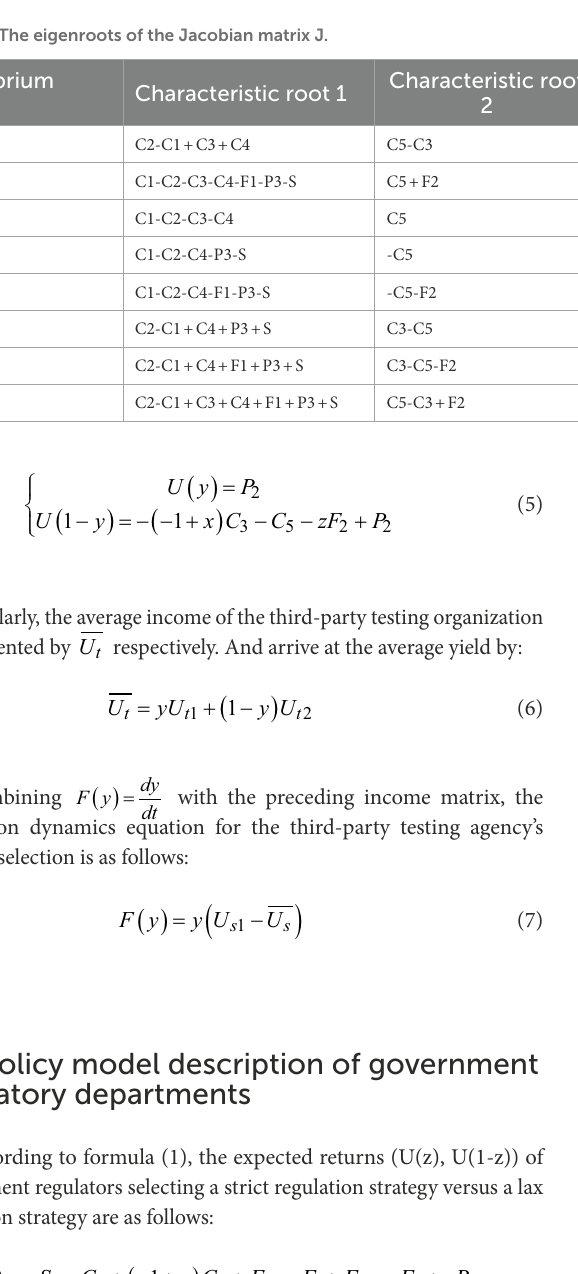
TABLE 3 The eigenroots of the Jacobian matrix J. Equilibrium point